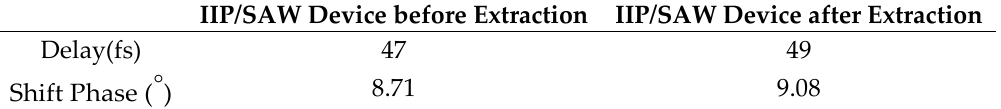
Figure 3. Displacement’s amplitudes in the x, y and z directions with time for: ( a ) the non imprinted polymer (NIP), ( b ) the IIP before extraction and ( c ) the IIP after extraction. Table 1. Comparison results of NIP/SAW sensor to IIP/SAW device before and after extraction.